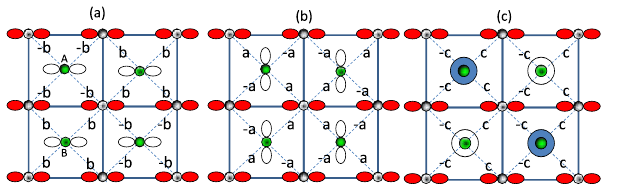
, y;xz j FIG. 9. The pattern of d